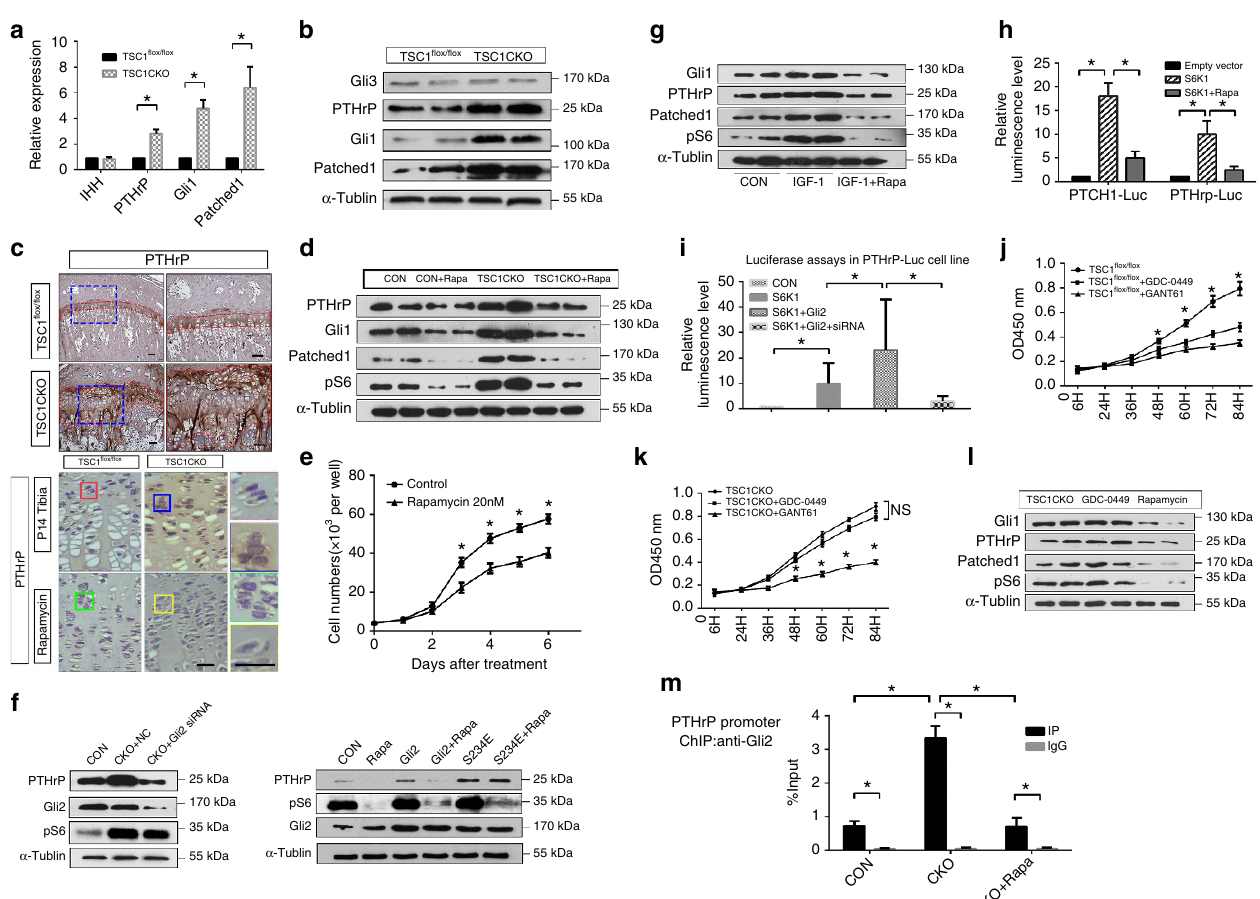
Figure 7 | mTORC1 activity is required for PTHrP transcription. ( a ) qPCR analysis of IHH, PTHrP, Patched1, Gli1 in primary cultured chondrocytes isolated from control and TSC1CKO mice. Student’s t -test, * P o 0.05, n Z 3; Error bars indicate s.d. ( b ) Western blot analysis showing PTHrP, Gli1, Gli3 and Patched1